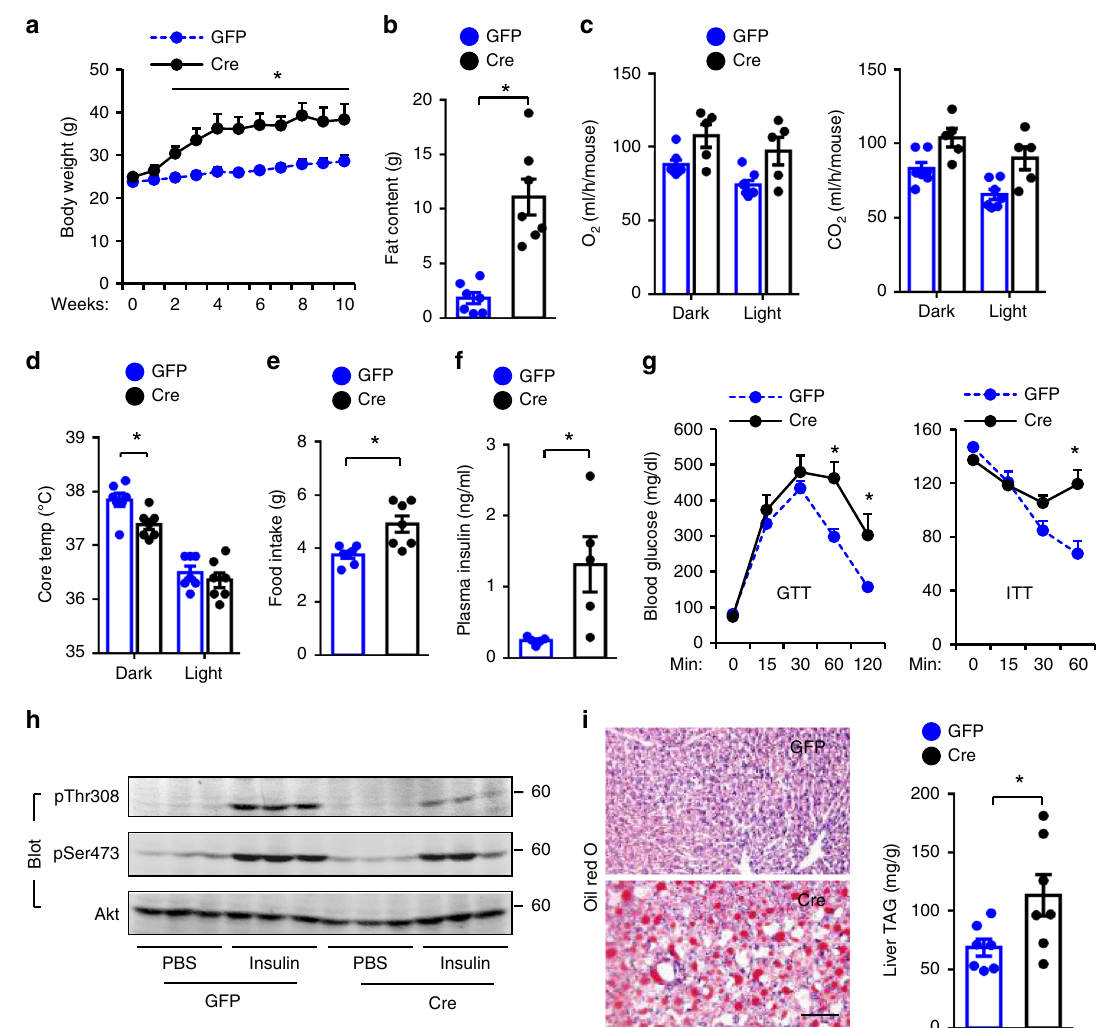
Fig. 3 Adult-onset, MBH-speci fi c ablation of Sh2b1 results in obesity, insulin resistance, and liver steatosis. AAV1-hSyn-Cre or AAV1-hSyn-GFP vectors were bilaterally injected into the MBH of Sh2b1 f/f males at 10 weeks of age. a Growth curves. b Fat content in 10 weeks post transduction. c Energy expenditure in 10 weeks after transduction. d Rectal temperature in 10 weeks following transduction. e Food intake at 10 weeks post transduction. f Overnight fasting plasma insulin levels in 10 weeks after transduction. g GTT and ITT in 10 – 11 weeks post transduction. h Mice were stimulated with insulin in 11 weeks post transduction. Liver extracts were immunoblotted with the indicated antibodies ( n = 3 mice per group). i Representative Oil Red O staining of liver sections and liver TAG levels (normalized to liver weight) in 11 weeks post transduction. a , b , d , e , g , i : AAV1-hSyn-GFP: n = 7, AAV1- hSyn-Cre: n = 7; c : AAV1-hSyn-GFP: n = 7, AAV1-hSyn-Cre: n = 5; f : AAV1-hSyn-GFP: n = 5, AAV1-hSyn-Cre: n = 5. Scale bar: 100 μ m. Data are